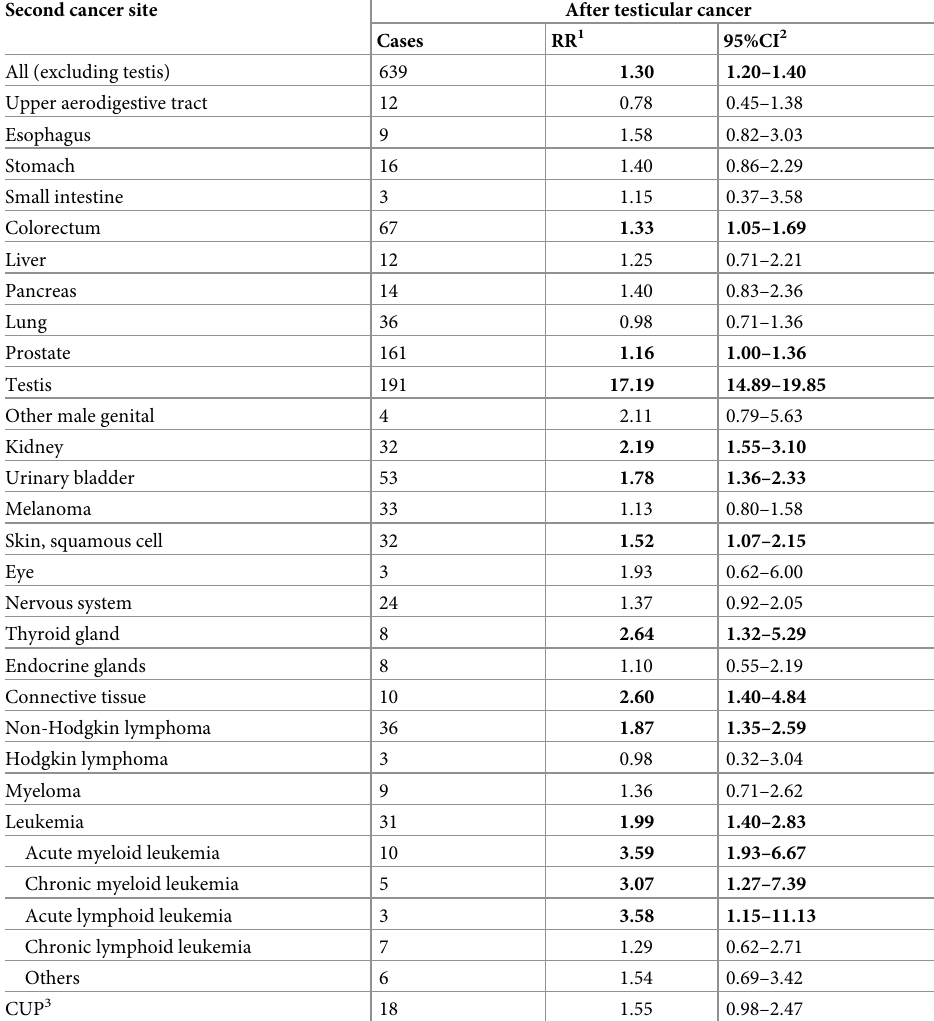
Table 2. RRs of second primary cancers in survivors of testicular cancer.